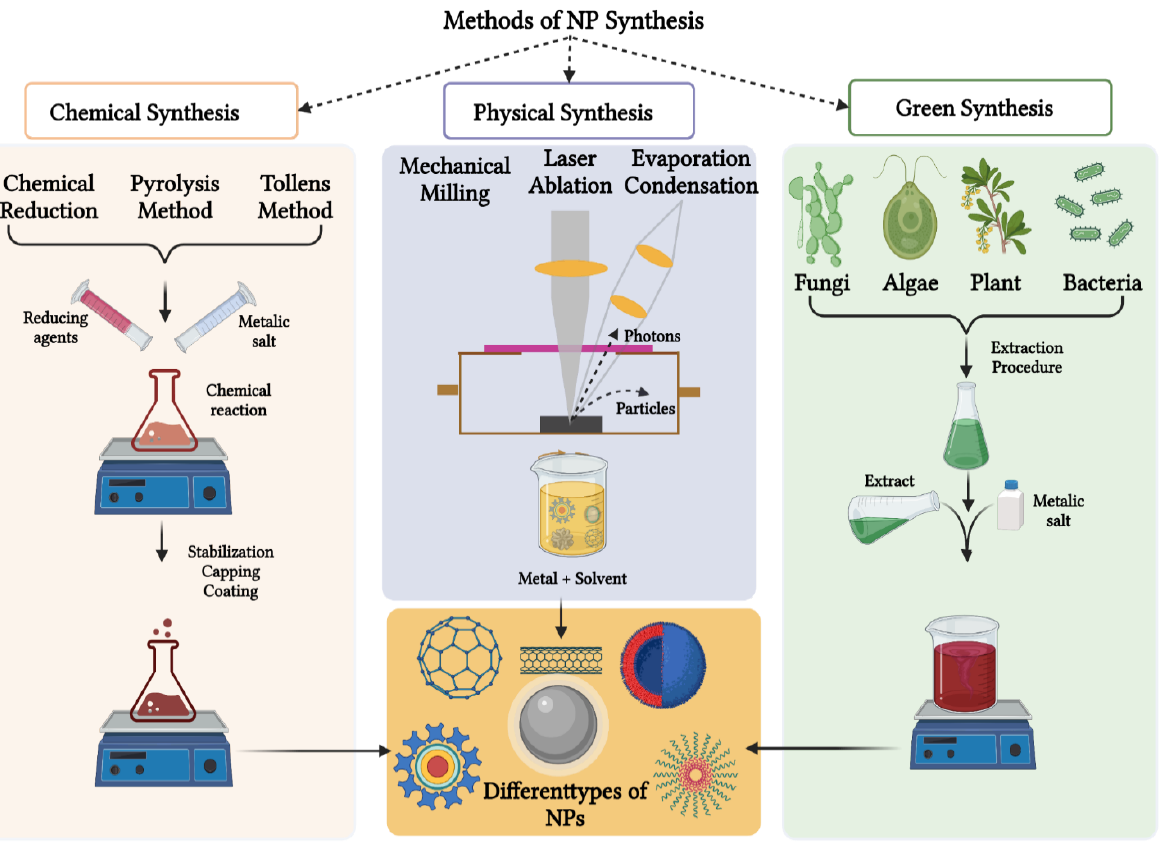
Figure 2. An overview of the synthesis of NPs using the chemical, physical and green synthesis methods. The bulk materials are crushed by physical methods to produce NPs, whereas the chemicals and natural products are used to reduce metal precursors into their respective NPs.